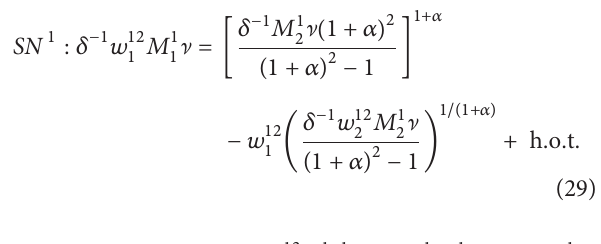
] | < 0 , 𝑤 12 𝑤 12 < 1 . 2 1 2